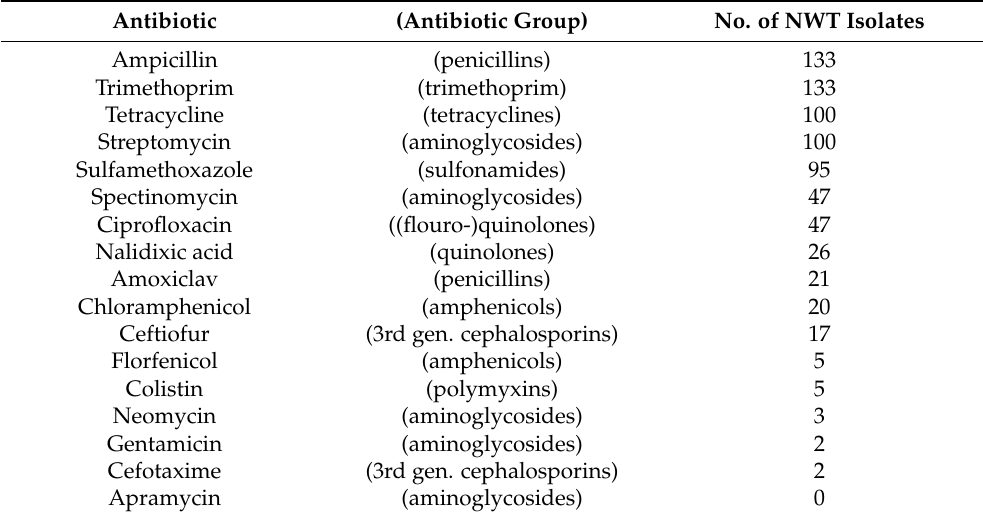
Table 9. Non-wildtypes (NWT) of Escherichia coli isolates from the weaning and growth samplings in Denmark (n = 374).